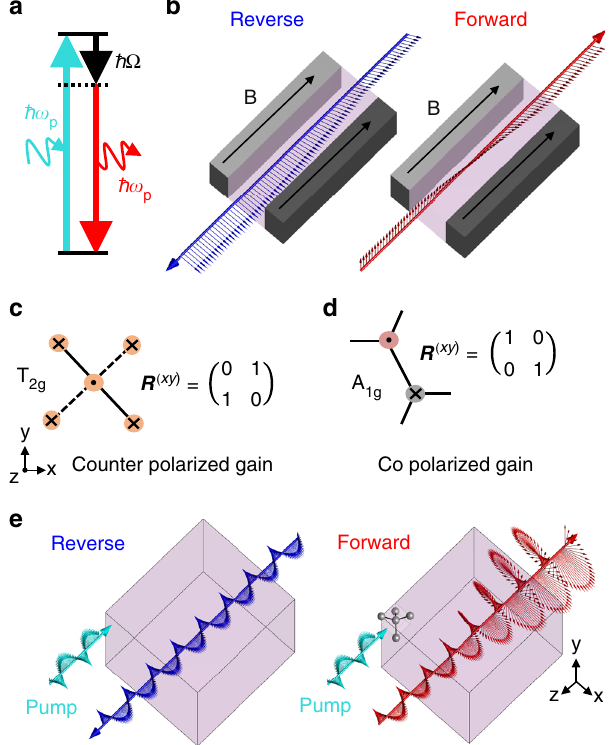
Fig. 1 Nonreciprocal stimulated Raman scattering. a Energy diagram for Raman decay of a pump photon into a Stokes photon and a phonon. b Nonreciprocal polarization rotation due to Faraday effect in magnetized medium. c , d Phonons that produce spin-polarized nonreciprocal SRS